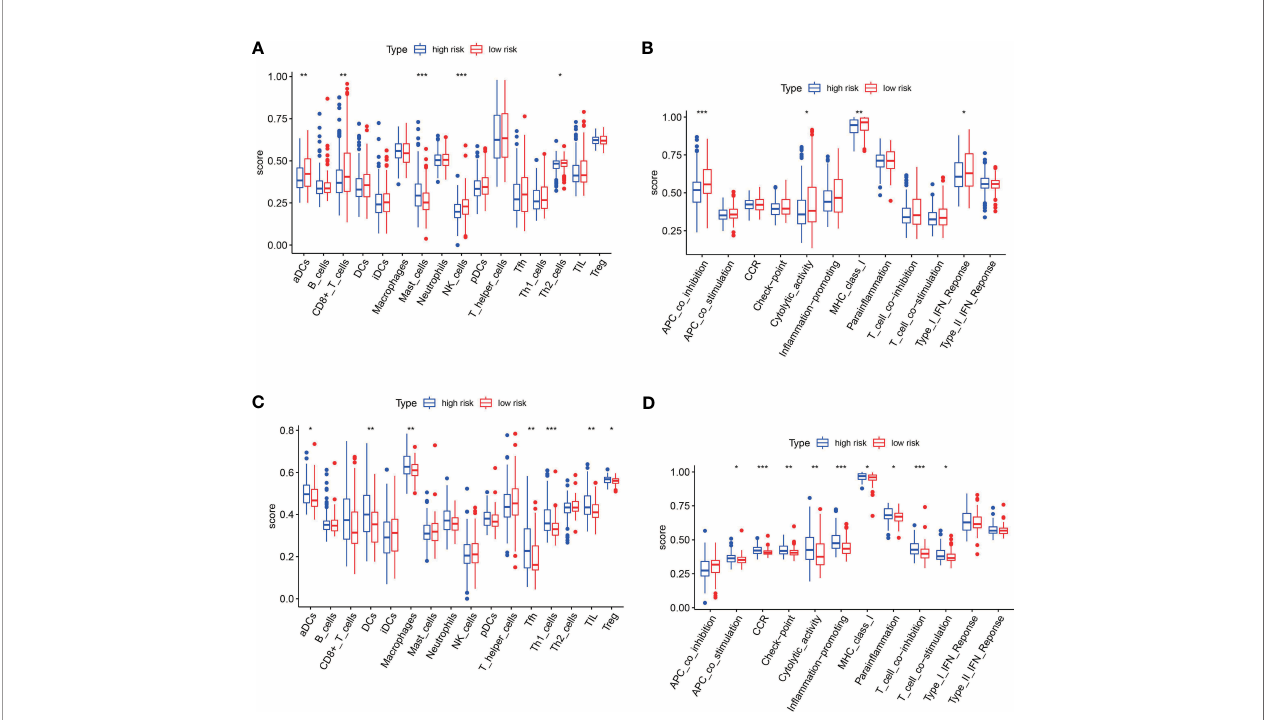
FIGURE 9 | The single-sample gene set enrichment analysis (ssGSEA) scores between the high-risk and low-risk group in TCGA and GEO cohorts. (A) Box plots showing the scores of 16 immune cells in different groups in the TCGA cohort. (B) Box plots showing the scores of 13 immune-related functions in different groups in the TCGA cohort. (C) Box plots showing the scores of 16 immune cells in different groups in the GEO cohort. (D) Box plots showing the scores of 13 immune- related functions in different groups in the GEO cohort. Adjusted p -values are shown as follows: * p < 0.05; ** p < 0.01; *** p <